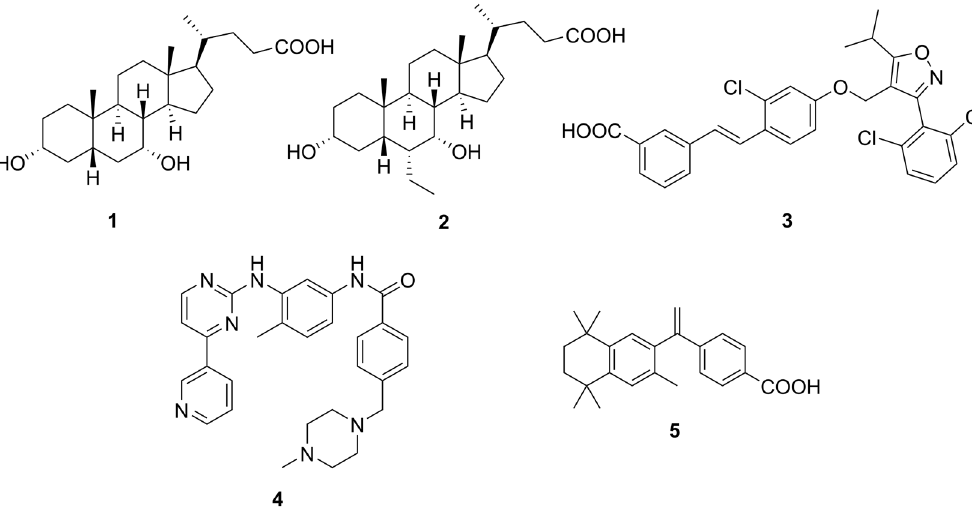
Figure 1. Chemical structures of endogenous FXR agonist chenodeoxycholic acid ( 1 , CDCA), first-in-class approved FXR targeting agent 6 α -ethyl-CDCA ( 2 , 6-ECDCA, INT-747, obeticholic acid, OCA) the widely- used reference FXR agonist GW4064 ( 3 ), imatinib ( 4 , CGP 57148B, STI 571, Gleevec ® ) and retinoid X receptor agonist bexarotene ( 5